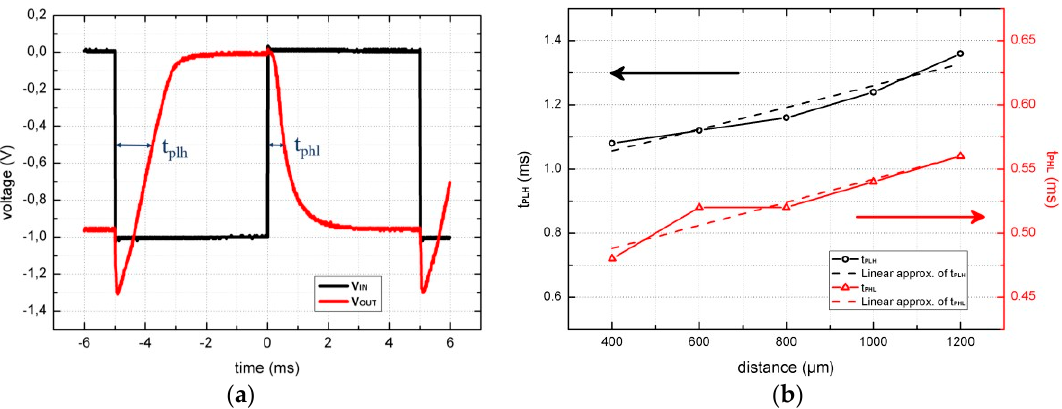
Figure 5. ( a ) V IN and V OUT vs. time curves of inverter for 1000 µm distance; ( b ) t phl and t plh vs. distance curves and their linear